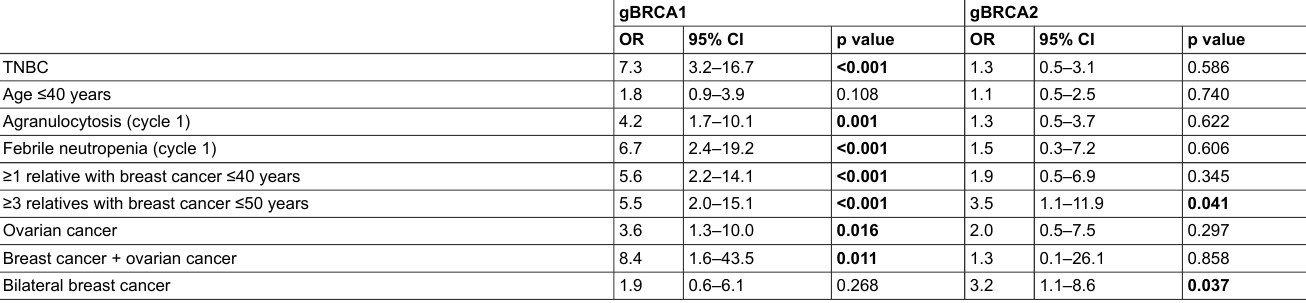
Table 3: Univariate analysis of breast cancer patients’ characteristics, haematological toxicity during C1, and family history according to gBRCA1 and gBRCA2 status.